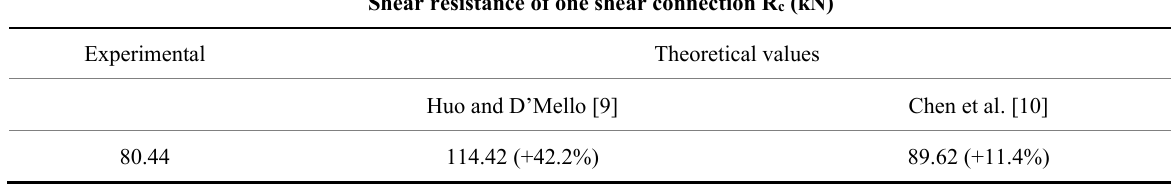
Table 4: Comparison of experimental shear resistance and analytical